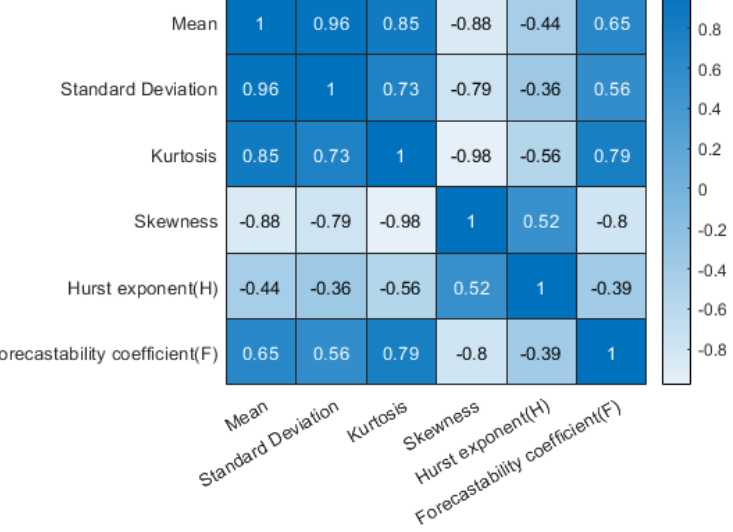
Figure 8. Descriptors correlations.